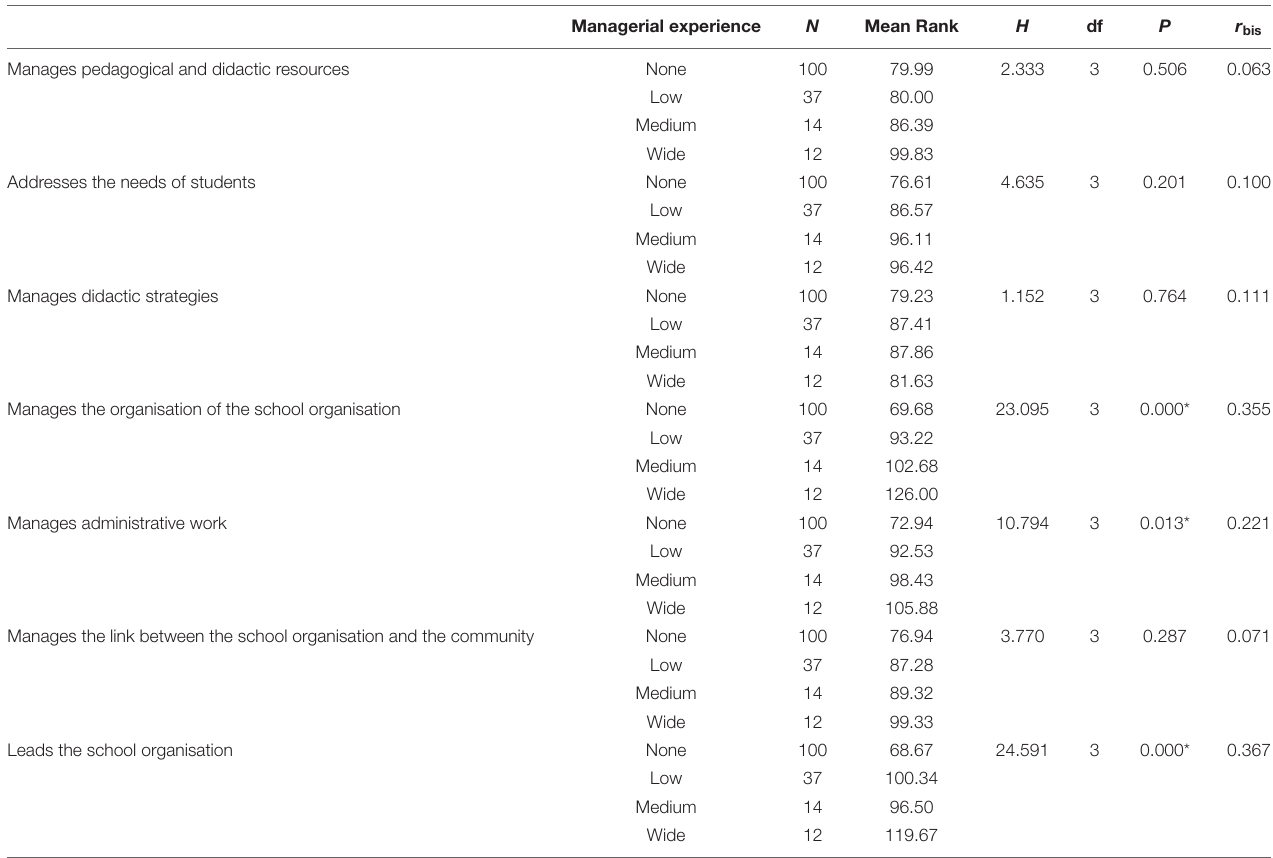
TABLE 7 | Results of Kruskal-Wallis H test level of managerial experience in